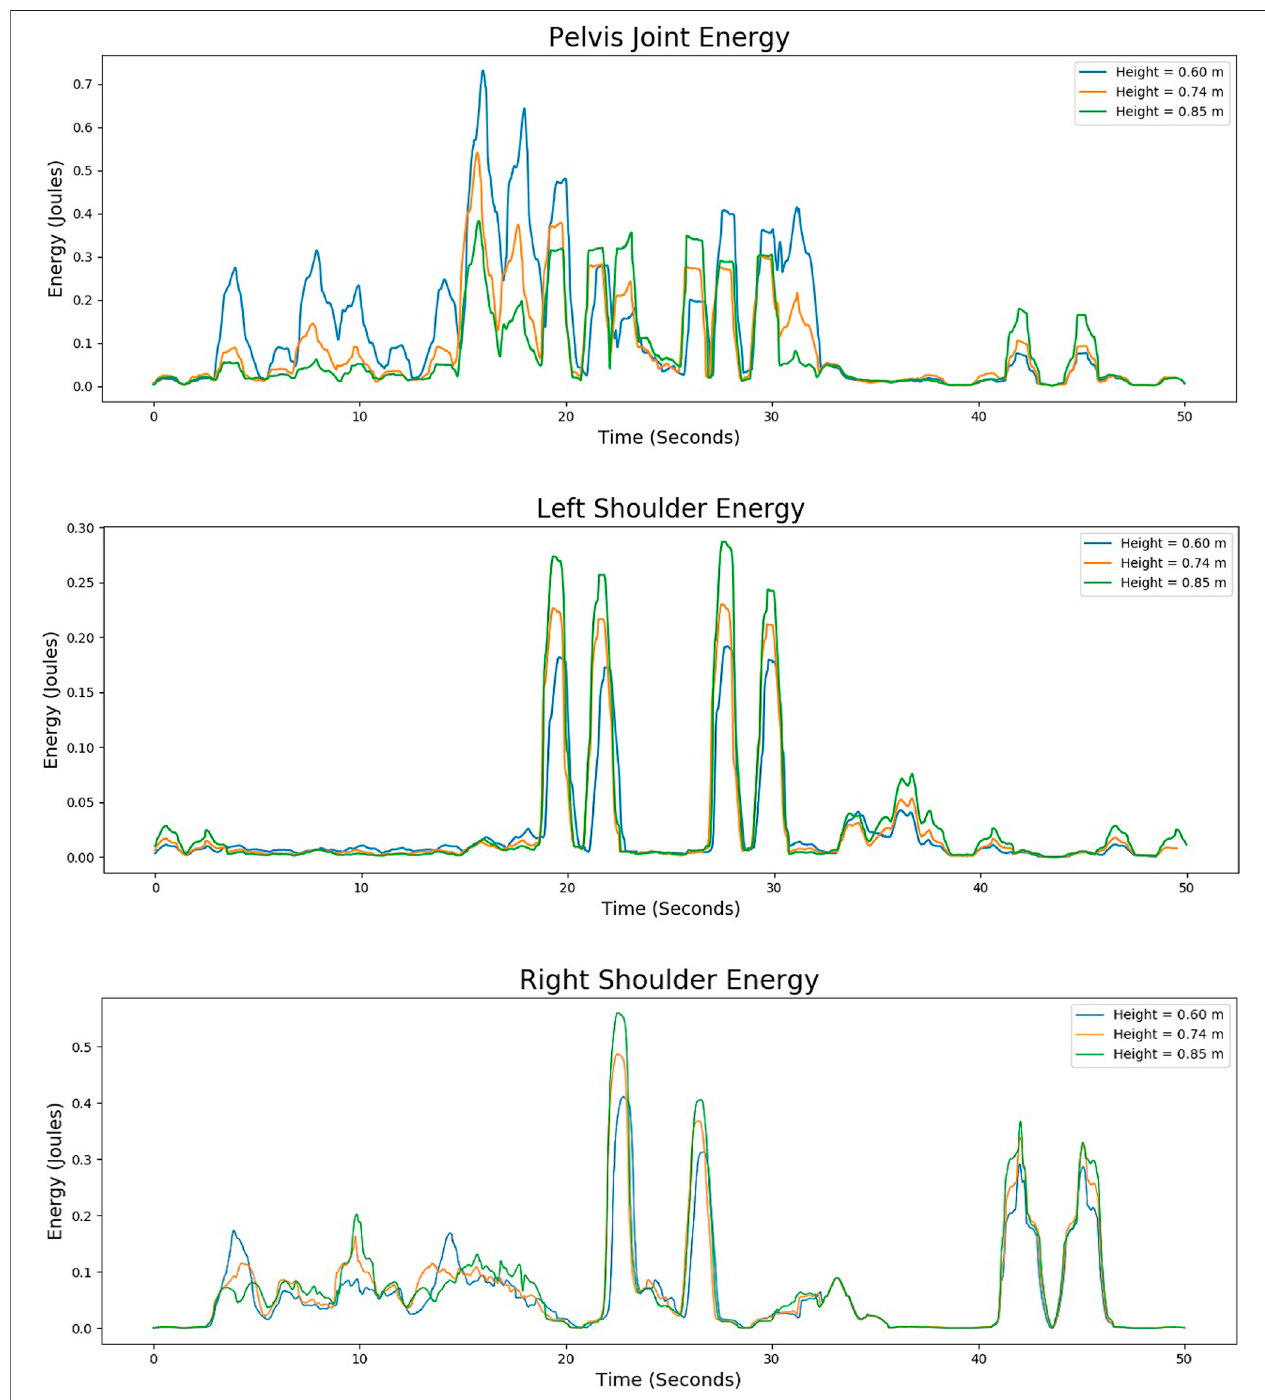
FIGURE 12 | Biophysics-based computation of energy expenditure in the pelvis, left and right shoulder over time for three different table heights.